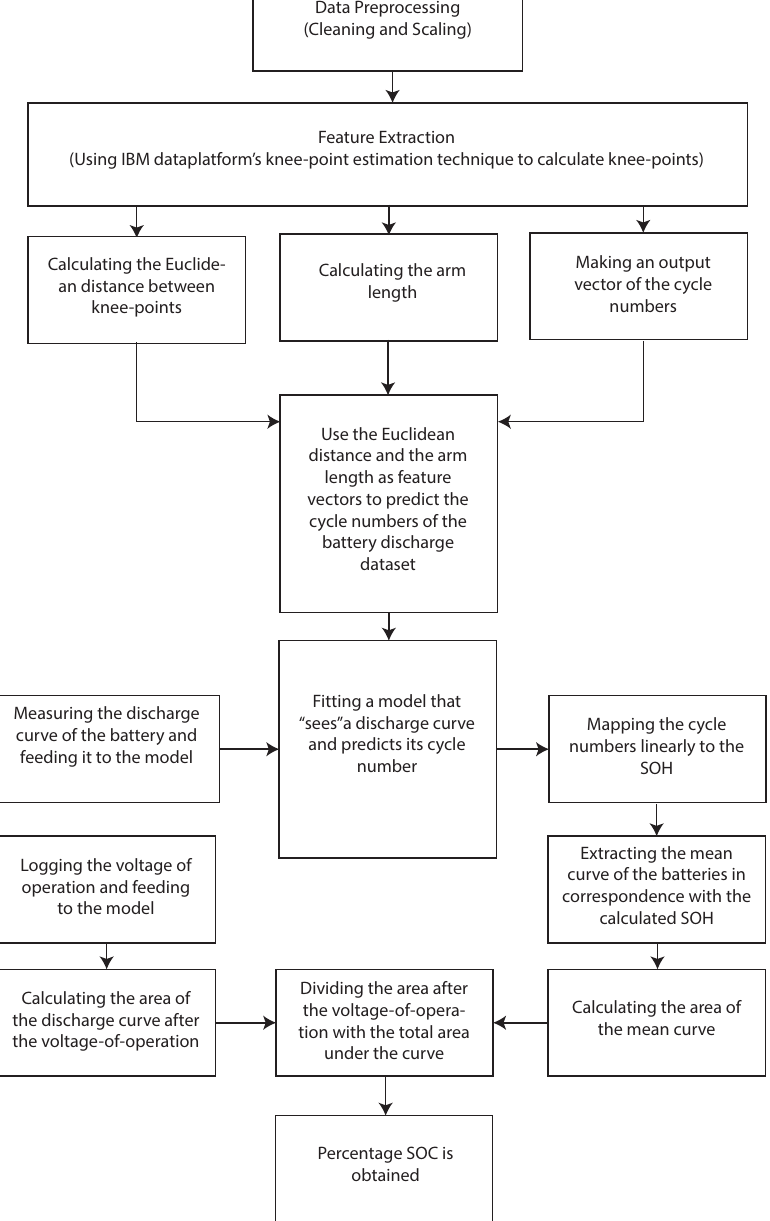
Figure 3. Block diagram of SOH and SOC estimation with machine